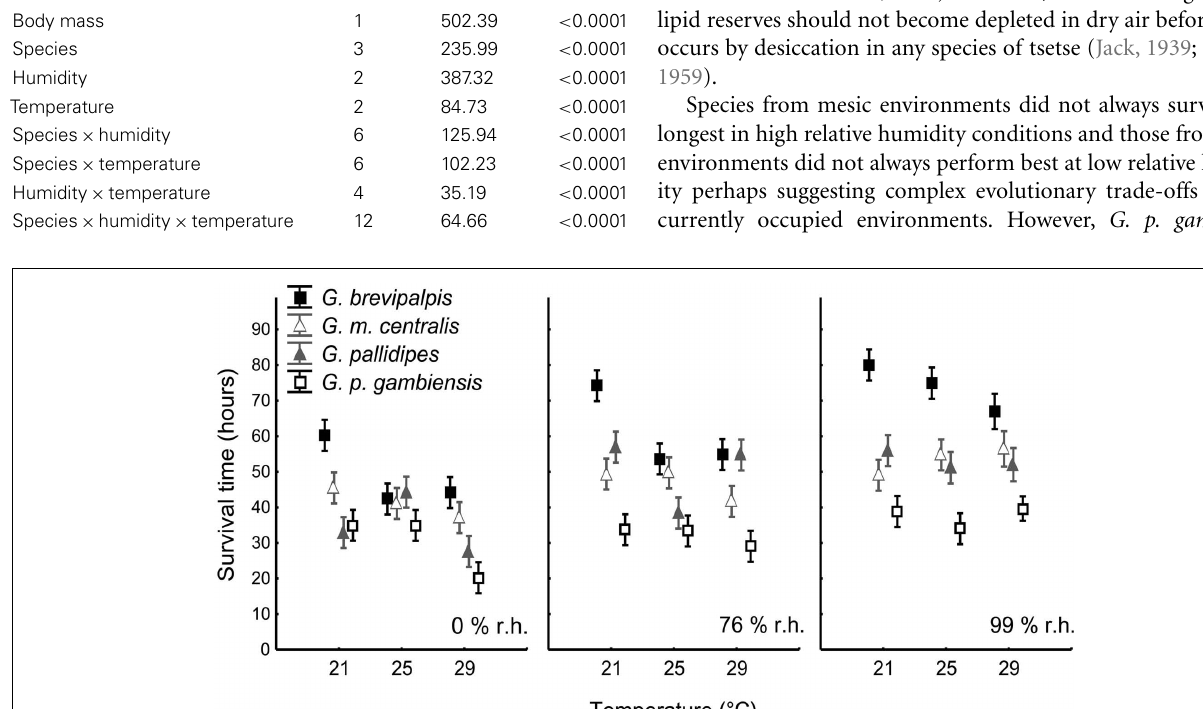
FIGURE 4 | Means ( ± 95% confidence intervals) for estimated survival time (in h) for Glossina brevipalpis (mesic) , G. m. centralis (xeric), G. pallidipes (xeric), and G. p. gambiensis (mesic) across the range of temperature and relative humidity treatments. Mesic species are presented by squares and xeric species by triangles. Survival time is